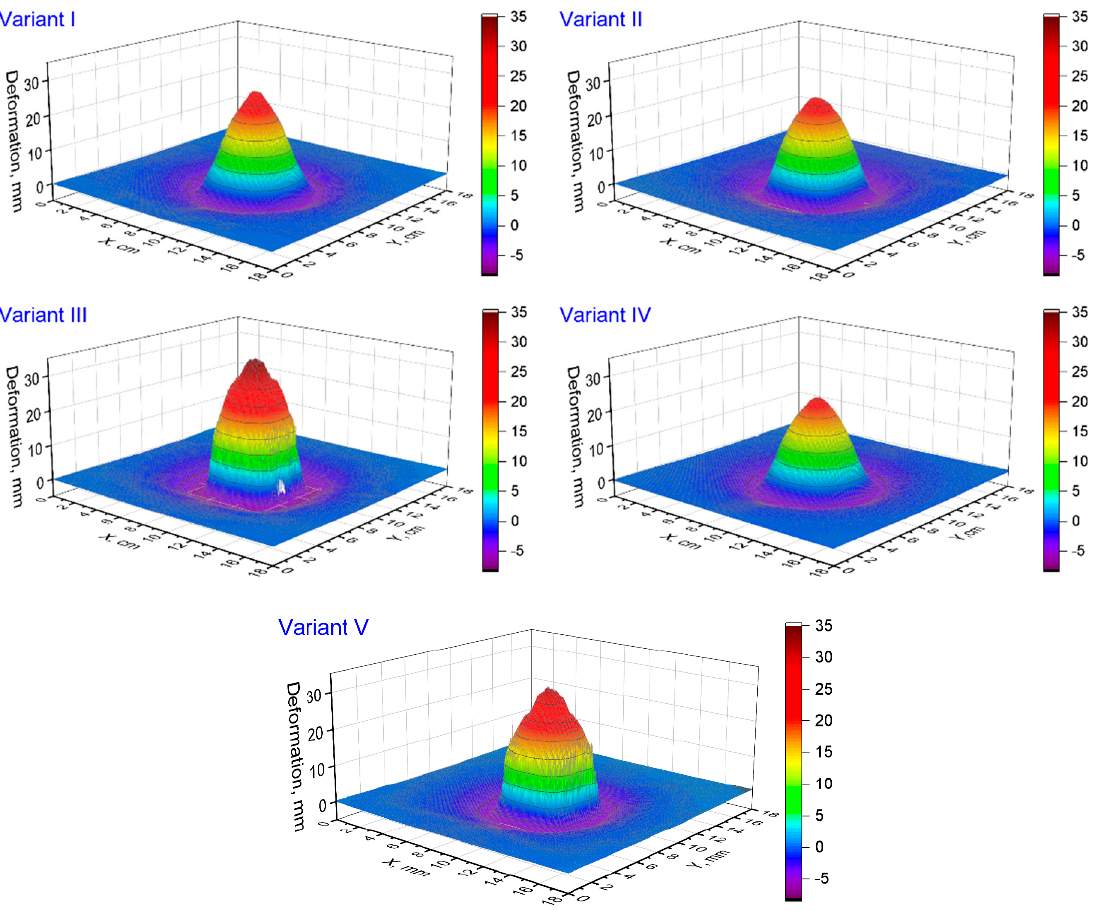
Figure 4. Deformation of the ballistic ground for individual variants of ballistic packages.